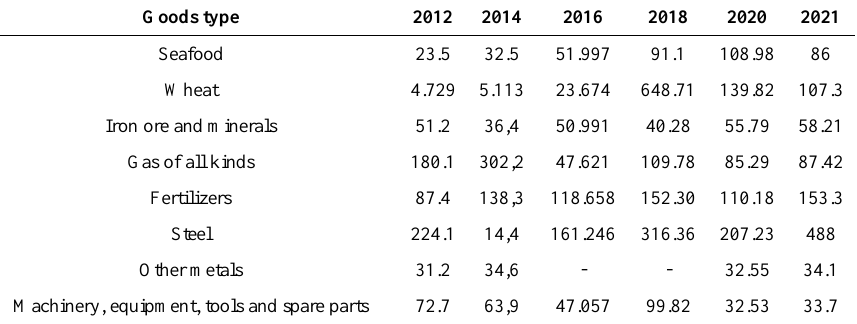
Table 2. Imports of certain goods into Vietnam from Russia from 2012 – 2021 ( Unit: Million